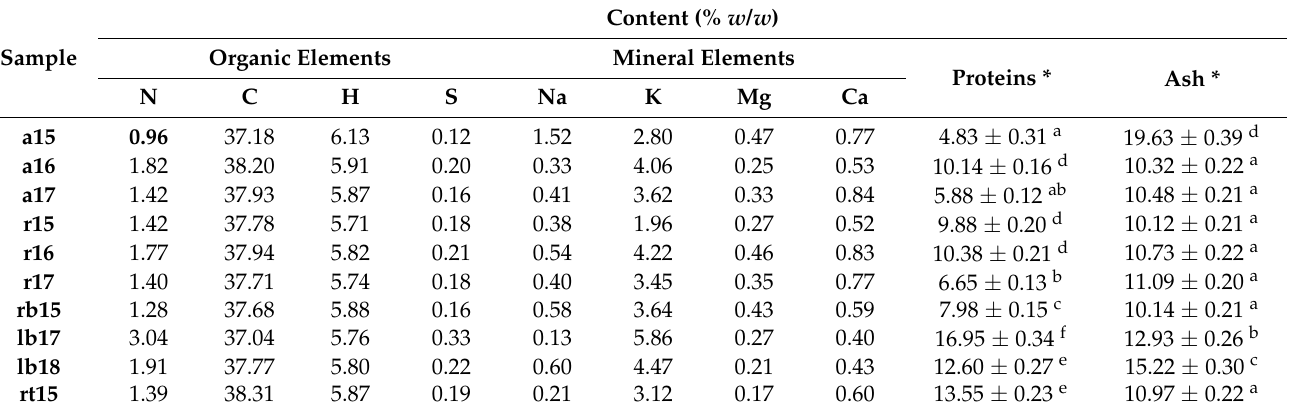
Table 3. Elemental composition, protein, and ash contents of FSM from various cultivars (proteins, ash: mean ± SD, N =